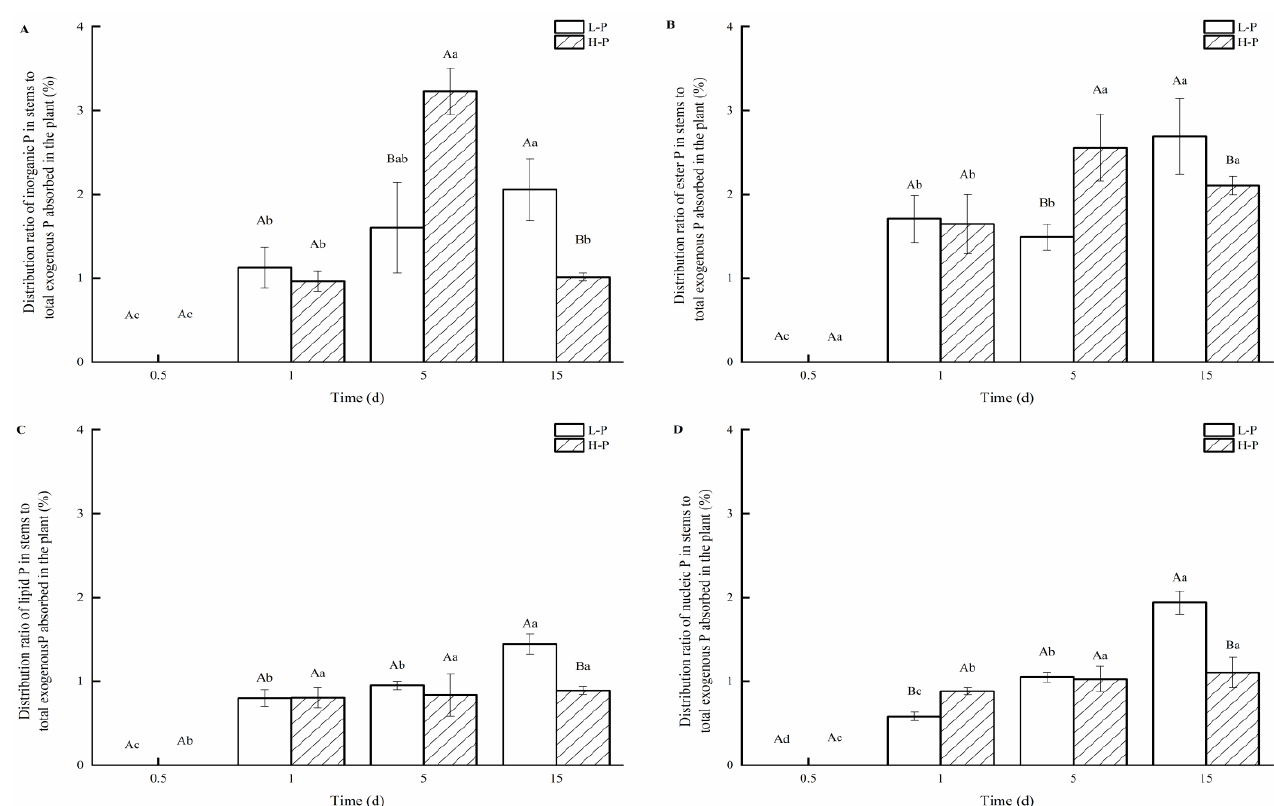
Figure 5. Percentage of different P fractions in stems to total exogenous P absorbed in the plant under high- and low-P treatments: ( A ) inorganic P, ( B ) ester P, ( C ) lipid P, and ( D ) nucleic P. “L-P” and “H-P” represent the low-P and high-P treatments, respectively. Error bars represent standard error, and each point in the figure represents the mean of the five replicates ( n = 5). Lowercase letters indicate significant differences ( p < 0.05) at different treatment times under the same P treatment. Uppercase letters indicate significant differences ( p < 0.05) between different treatments at each time point.